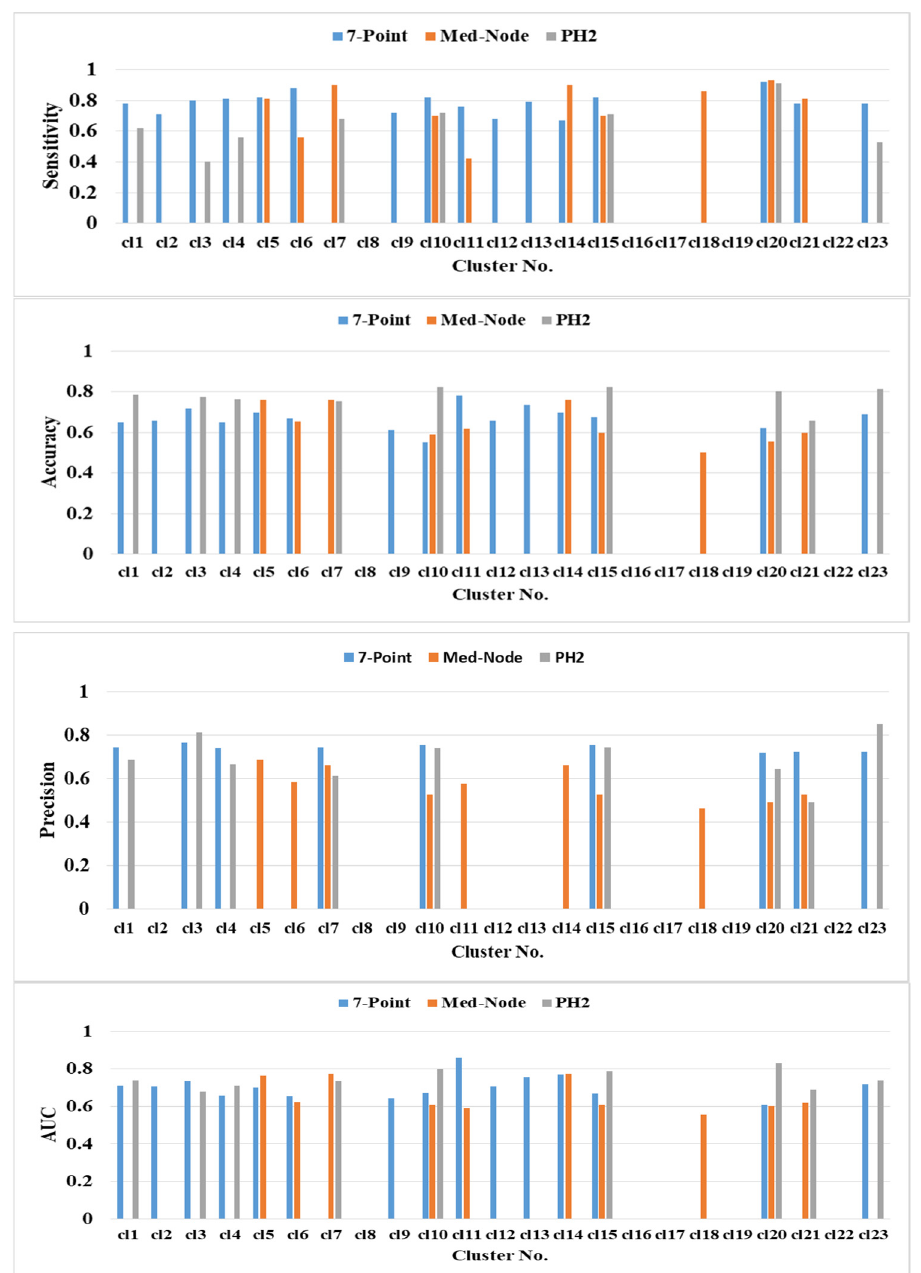
Figure 6. The prediction performance for the 5-fold cross validation and kNN classifier for different average percentage of color areas/color cluster descriptors.